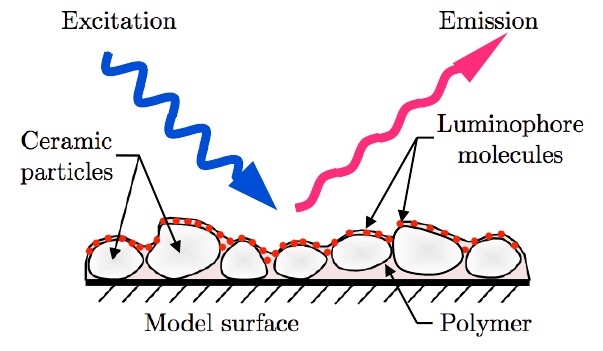
Figure 1. Schematic of Polymer/Ceramic Pressure-Sensitive Paint